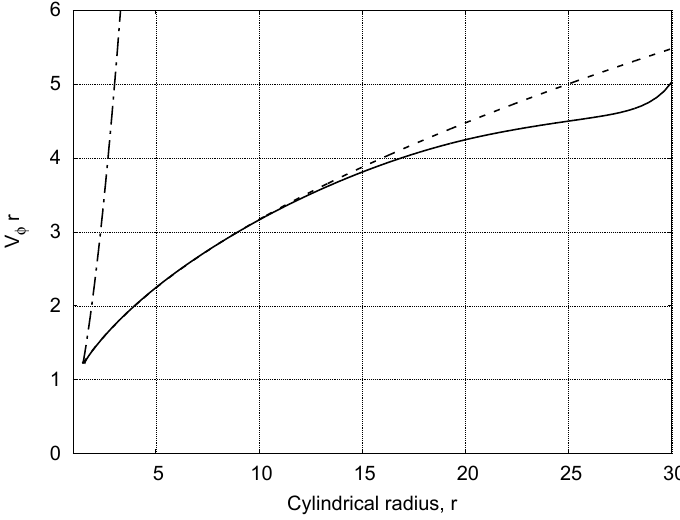
Figure 10. Distribution of the angular momentum of the flow at the equatorial plane (solid line). Dashed line—angular momentum at the Keplerian rotation, and dashed-dotted line—angular mo- mentum at the rigid rotation. The equatorial flow at ω = 1.01 is Keplerian up to 15 stellar radius.